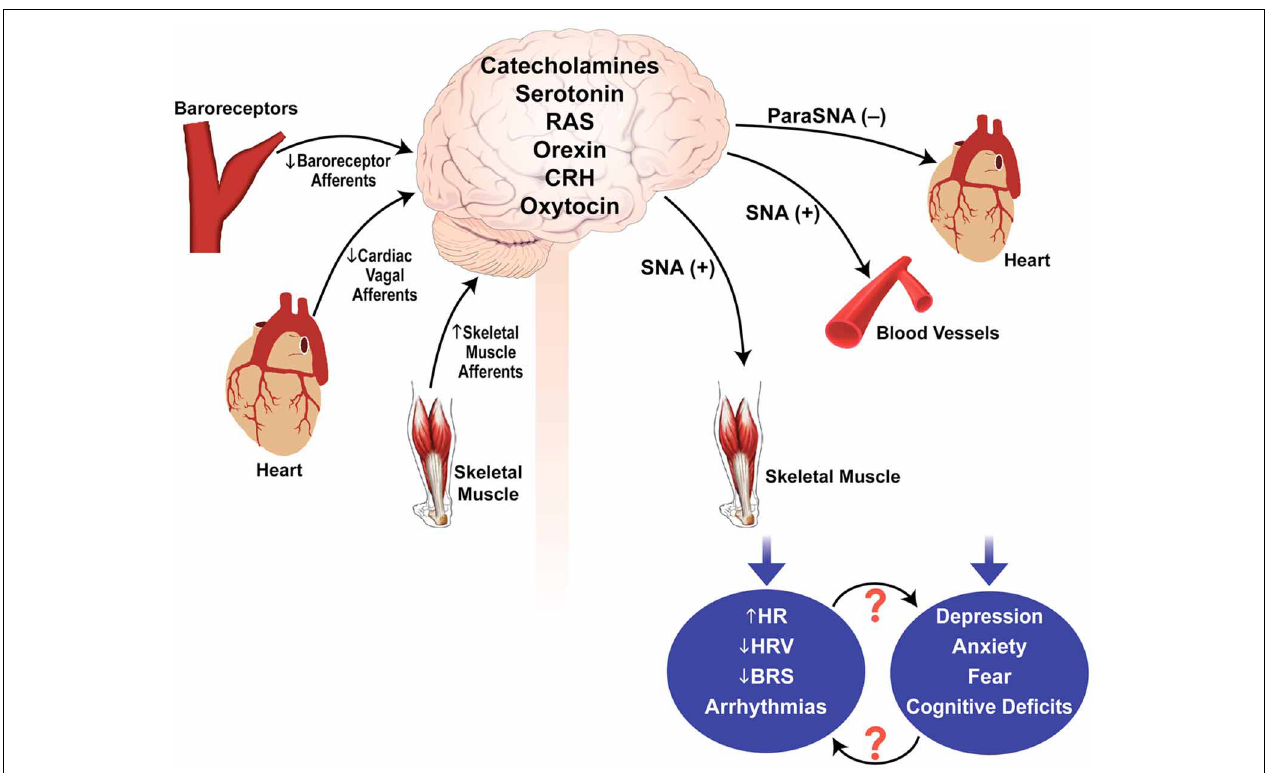
FIGURE 1 | Possible mechanisms involved in autonomic dysfunction and psychological stress in muscular dystrophy. Sensory input by the baroreceptor afferents, cardiac vagal afferents, and skeletal muscle afferents are integrated within the brain to modulate parasympathetic and sympathetic outflows. Disturbances in the sensory inputs and/or central integration and